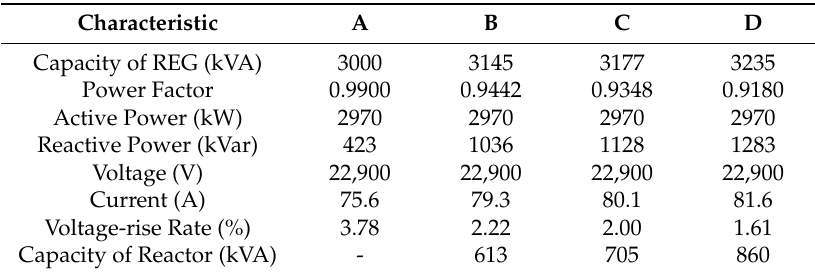
Table 3. Voltage rise rate according to reactor